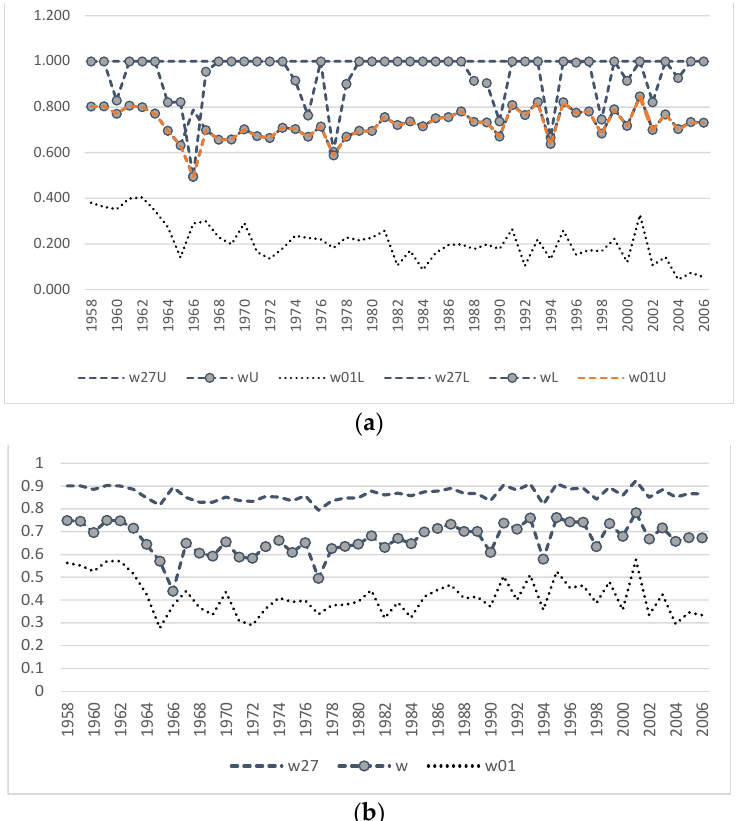
Figure A2. ( a )—Dynamics of the estimates of upper and lower bounds of the survival rate of males from birth to one year ( w 01L , w 01U ), subadults ( w 27L , w 27U ), and bulls ( w L , w U ). ( b )—Average values of the survival rates. Regression analysis [25] has shown that both sets of estimates (obtained by both the iteration and fitting method) are consistent with the observation data.